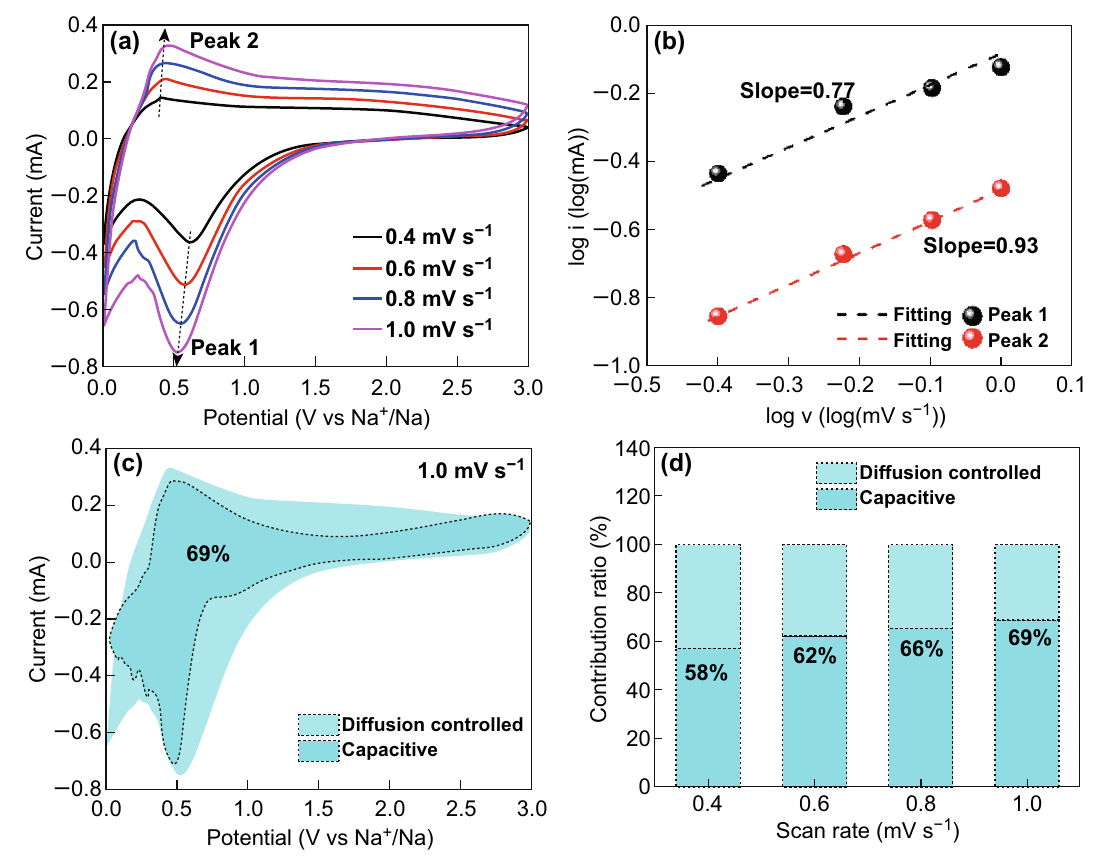
Fig. 7 a CV curves of SC-800 at different sweep rates after cycling. b Relationship between log( i ) and log( v ) for SC-800. c Voltammetric response (1.0 mV s −1 ) for SC-800 and d contributions of the capacitive and diffusion-controlled charges at different sweep